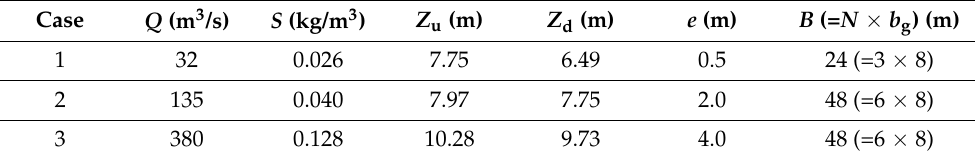
Figure 5. Grain-size distribution of sediment, with D = 0.002–0.90 mm and D 50 = 0.014 mm. Table 1. Typical flow and sediment cases of the sluice